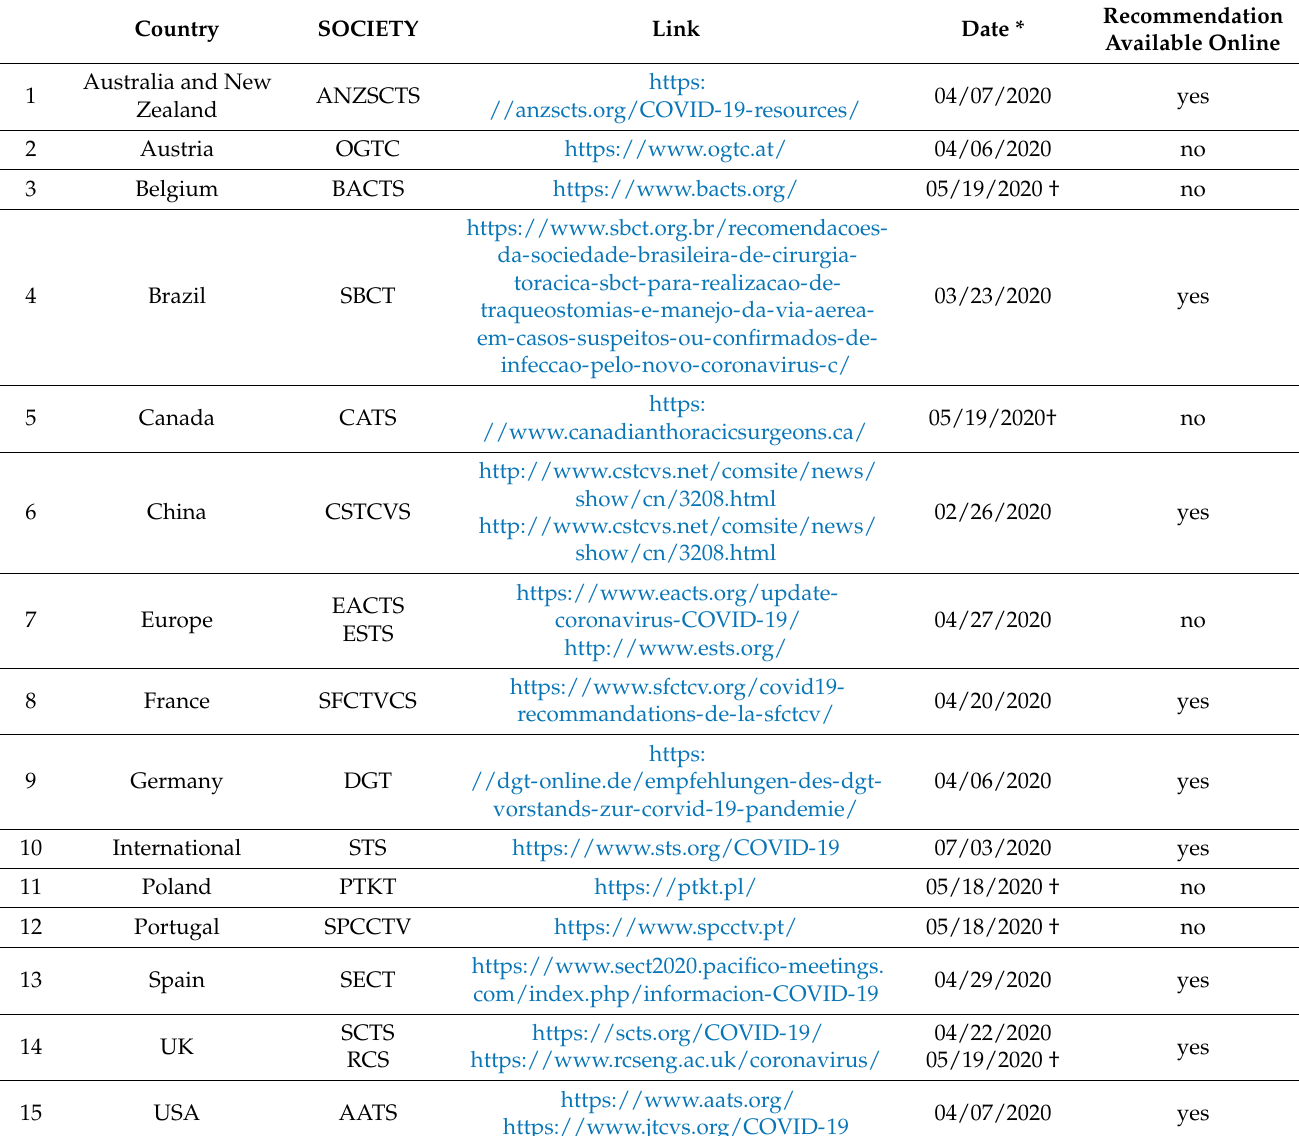
Table 1. Thoracic societies, access and recommendation